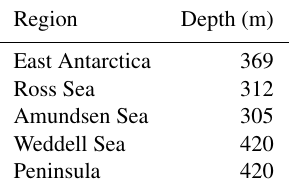
Table 1. Mean depth of ice shelves in the different regions denoted in Fig. 2 as computed from Le Brocq et al. (2010), consistent with the previous study (Levermann et al., 2014) in order to make the results comparable. Oceanic temperature anomalies were averaged vertically over a range of 100m around these